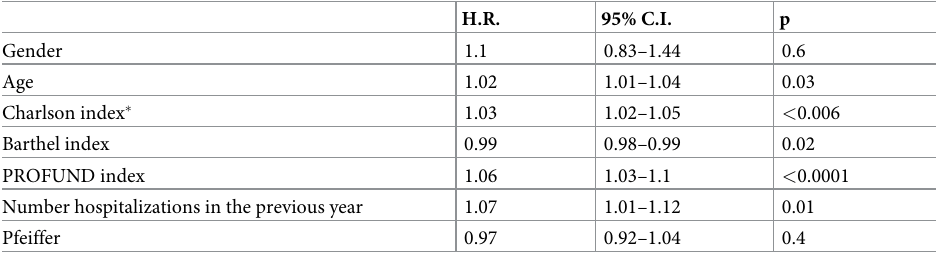
Table 4. Multivariate 1-year mortality